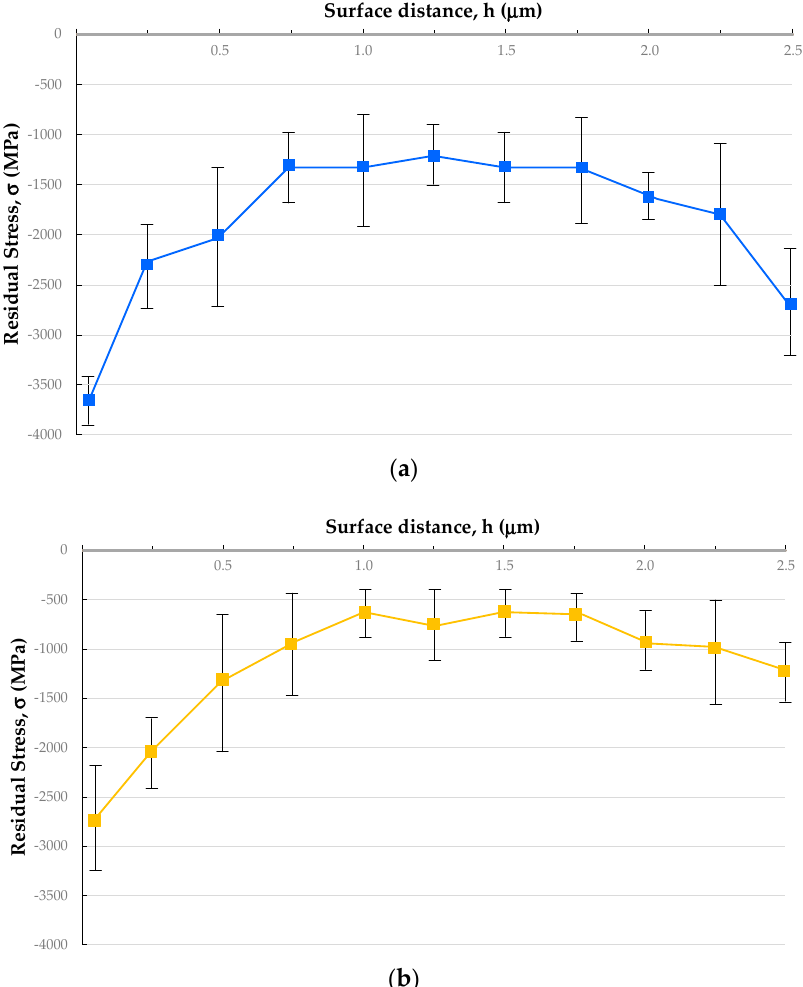
Figure 6. Values of residual stresses in DLCs deposited on different samples: ( a ) coating without sublayer and ( b ) coating with sublayer (CrAlSi)N.